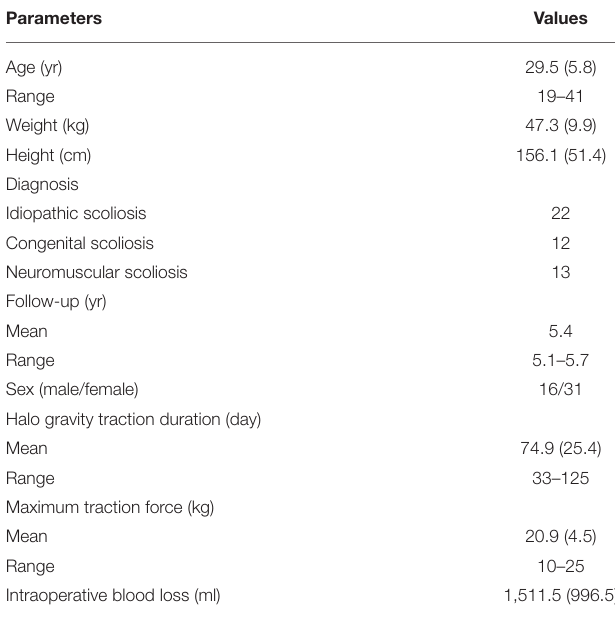
TABLE 1 | Characteristics of the patients included in the